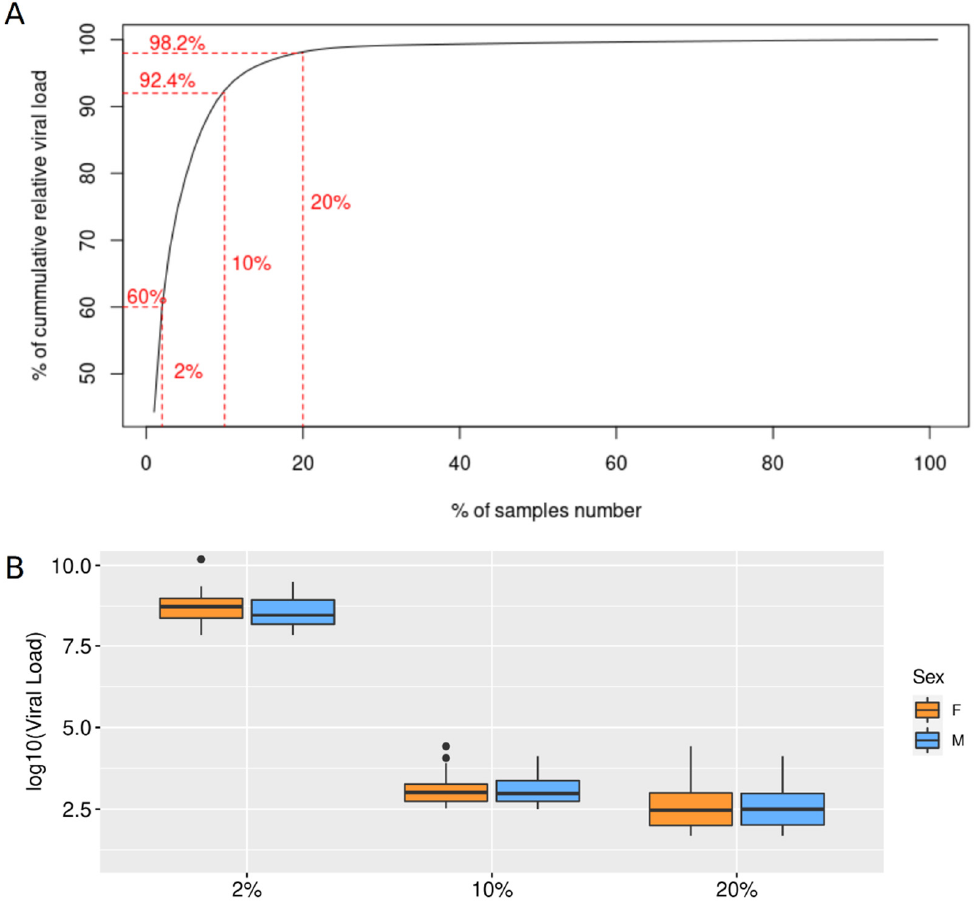
Figure 2. Distribution of the relative quantification of the SARS-CoV-2 viral loads (RQVL) within our population of 1119 samples. ( A ) Cumulative percentage of total circulating virions from nasopharynx RQVL within our population. ( B ) RQVL percentile comparative analysis between female (orange) and male (blue) in groups A (2%), B (10%), and C (20%), respectively. The gamma-generalized linear model showed a statistical significance difference among the sex of the supercarriers in each group, with a higher relative viral load reported among males, as demonstrated in Table S4.